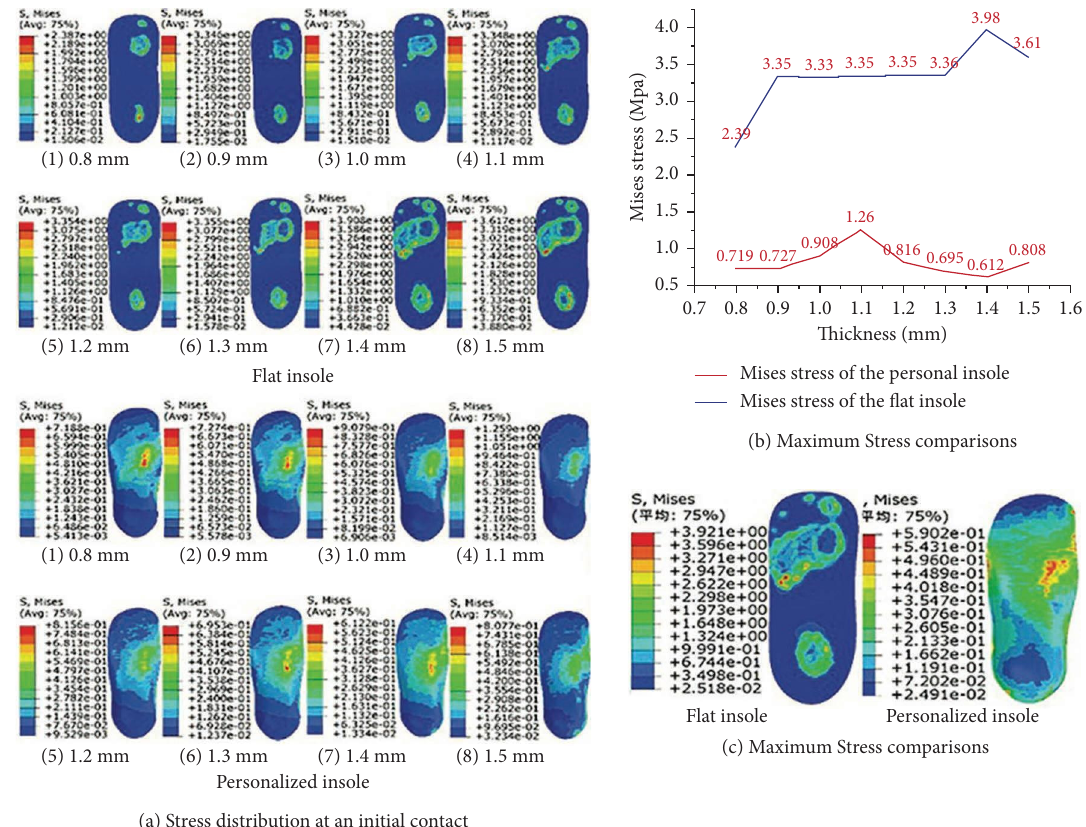
Figure 24: Stress distribution comparison. (a) Stress distribution at an initial contact stage with varied insole thickness. (b) Maximum stress comparisons. (c) Maximum stress